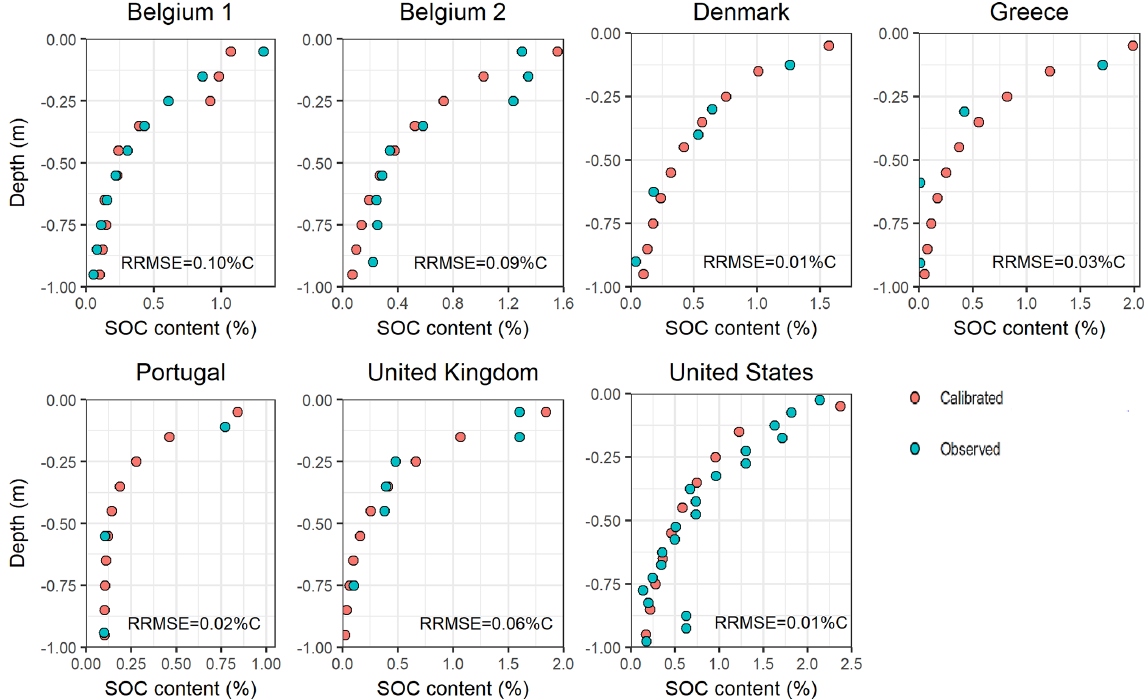
Figure 3. Measured (blue) and optimized (red) SOC profiles that were used to initialize the